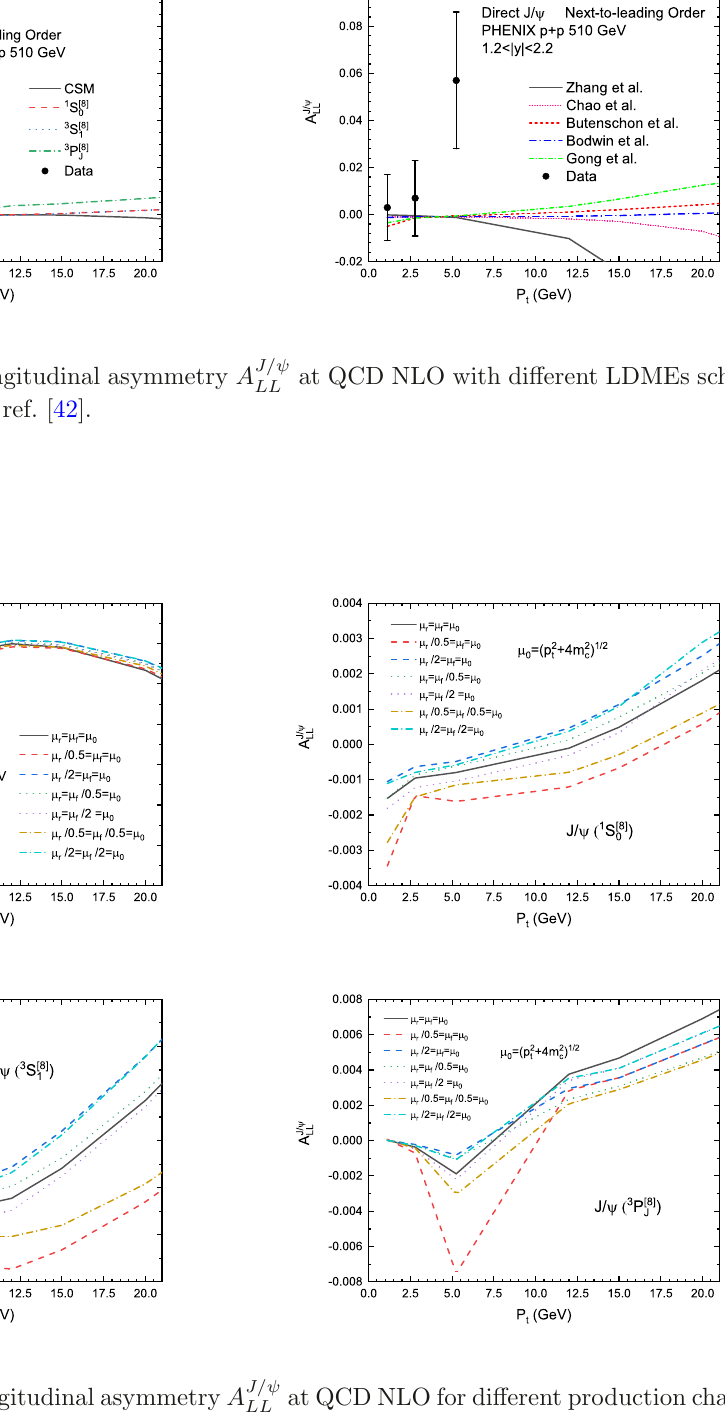
at QCD NLO for different production LL